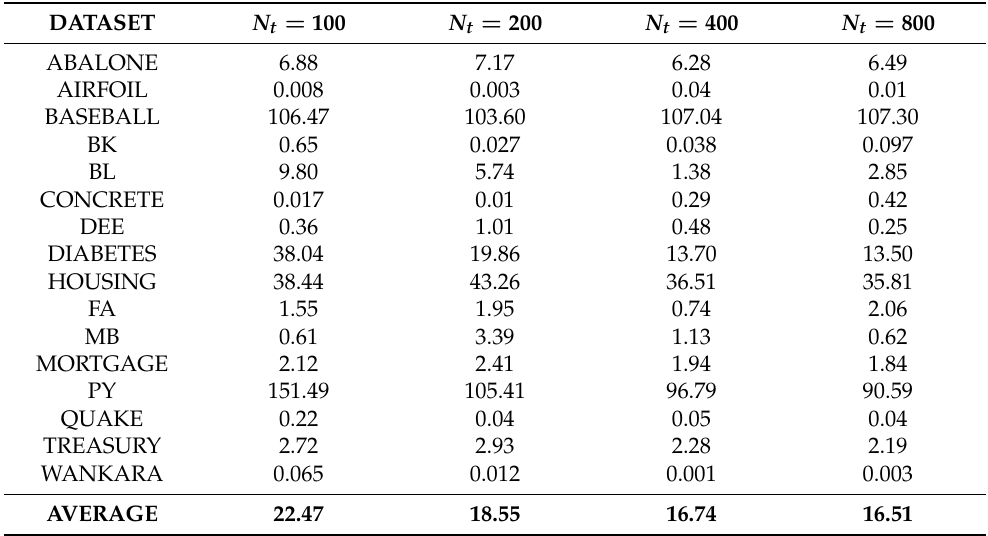
Table 7. Experiments with the genetic method and various values of N t for the regression